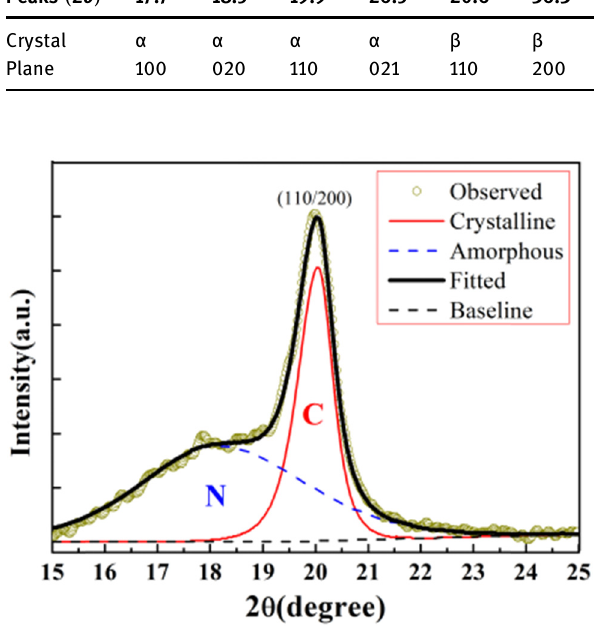
Figure 2: Deconvolution of the XRD spectra into the crystal peak and the amorphous peak [ 4 ] .